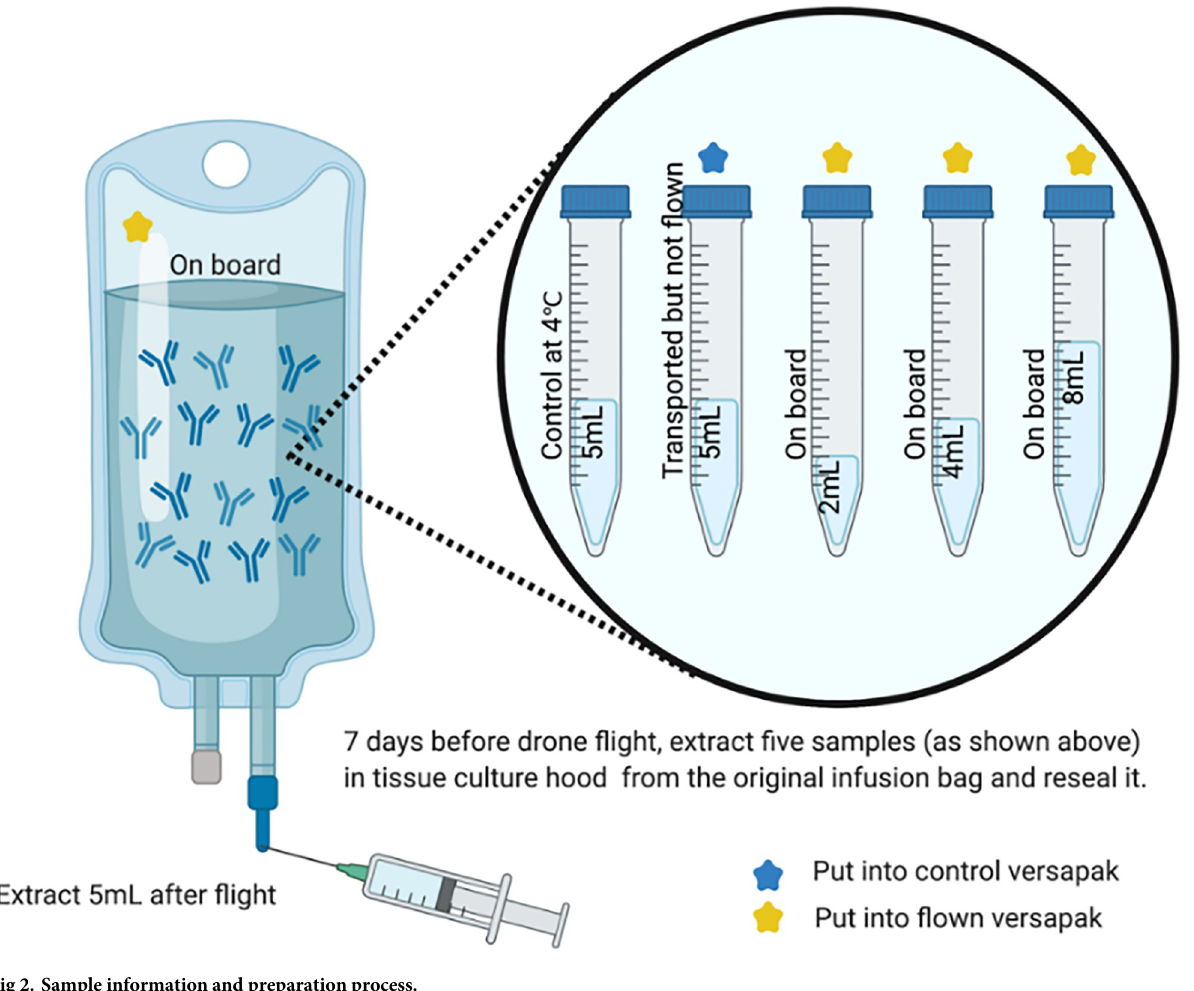
Fig 2. Sample information and preparation